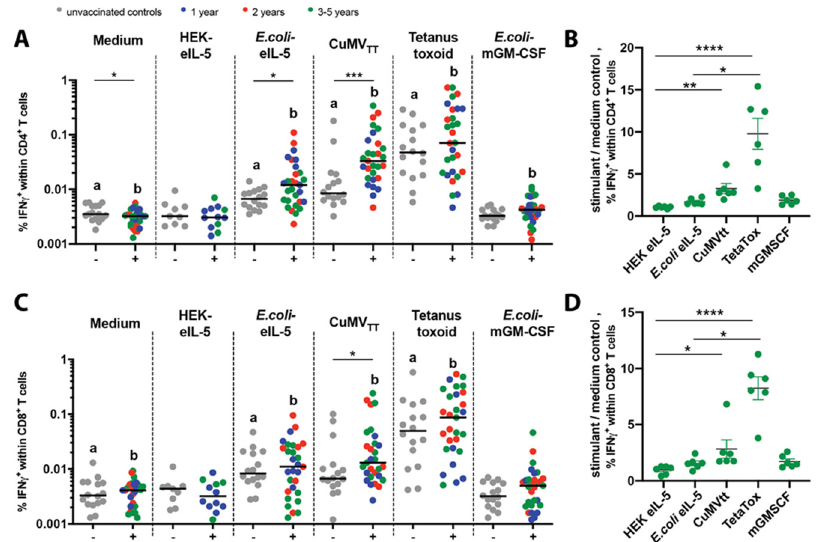
Figure 1. No auto-reactive CD4 + and CD8+ T cells upon the in vitro re-stimulation of peripheral blood mononuclear cells (PBMCs) from the vaccinated and control horses. In vitro re-stimulation using the medium control, HEK-eIL-5, E. coli -eIL-5, CuMV TT , tetanus toxoid (TetaTox), or E. coli -mGM-CSF of PBMCs from unvaccinated ( − ) control horses (grey) and 1 st (blue), 2 nd (red), or 3–5 (green) year vaccinated (+) horses. ( A,B ) CD4 + T cells, percentages of IFN γ -producing cells (A), percentages of IFN γ -producing cells of quotient stimuli/medium (B). (C,D) CD8 + T cells, percentages of IFN γ - producing cells (C), percentages of IFN γ -producing cells of quotient stimuli/medium (D). Values of individual horses with median on a log scale. Differences between the unvaccinated ( − ) controls and vaccinated (+) horses were analyzed with the Mann-Whitney U test. The medium unstimulated cells were compared to the stimulated cells by the Wilcoxon matched pairs rank with Bonferroni correction. There are significant differences between the unstimulated and stimulated cells within groups indicated with a for the controls and b for vaccinated horses. Medium corrected samples were analyzed by Kruskal–Wallis with Dunn’s multiple comparison. * p < 0.05; ** p < 0.01; *** p < 0.001; **** p < 0.0001.